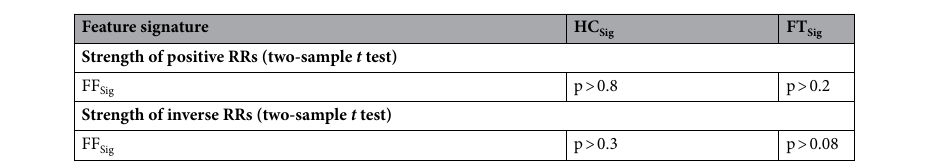
Table 2. Two-sample t tests that assess the strengths of all RRs constructed using the FF Sig with HC Sig and FT Sig , in both statistical directions on the NRG-S dataset.